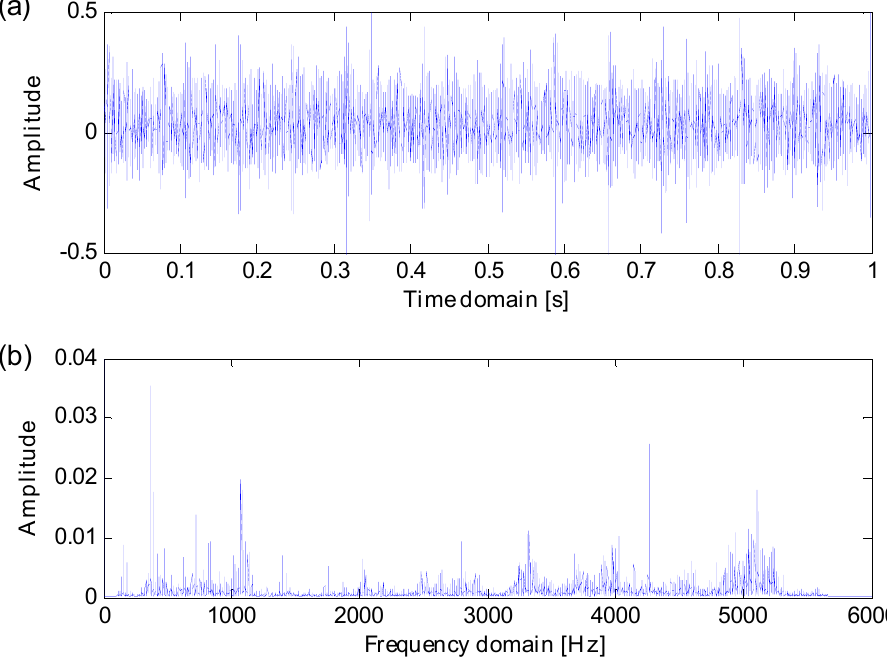
Figure 12. ( a ) Data X171_FE in time domain; ( b ) the spectrum of X171_FE in frequency domain.